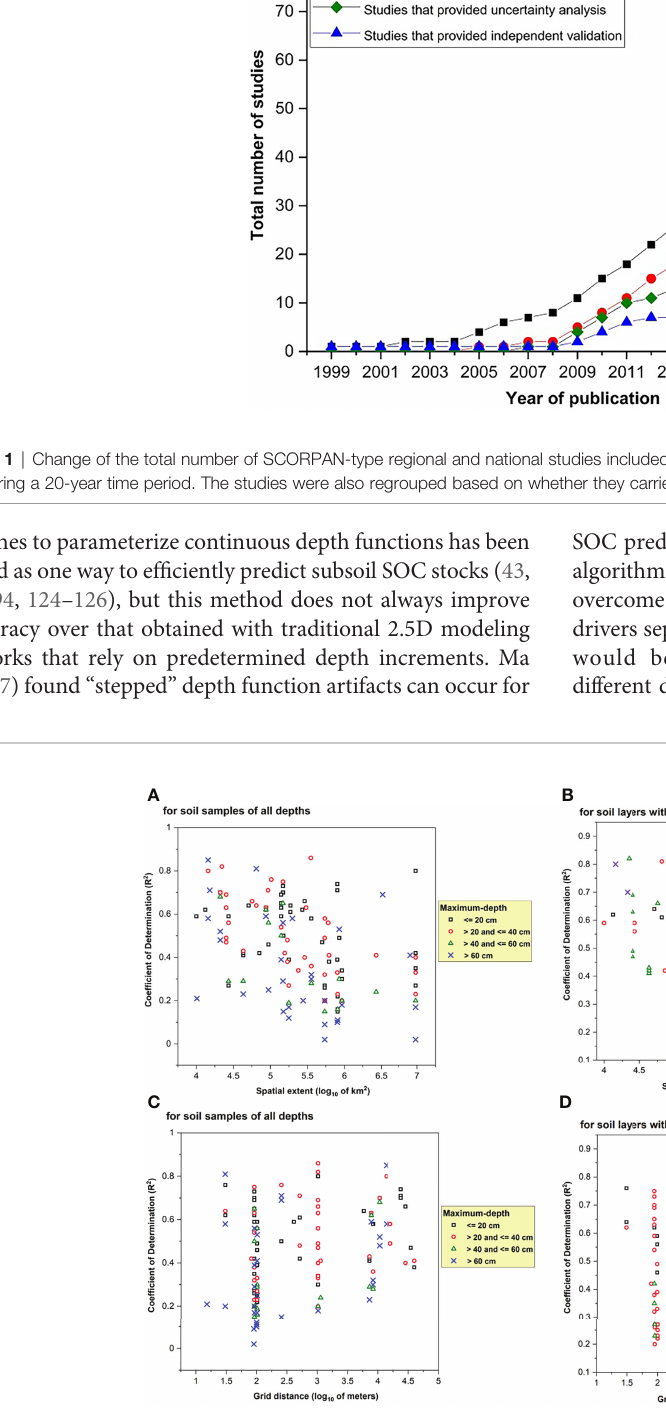
FIGURE 2 | SCORPAN-type model performance on soil organic C quanti fi cation from agricultural lands represented by Coef fi cient of Determination (R 2 ) grouped by (A) spatial extent and sampling depth, (B) spatial extent and grid-distance for surface soil layers, (C) grid-distance and sampling depth, and (D) grid-distance and spatial extent for surface soil layers.